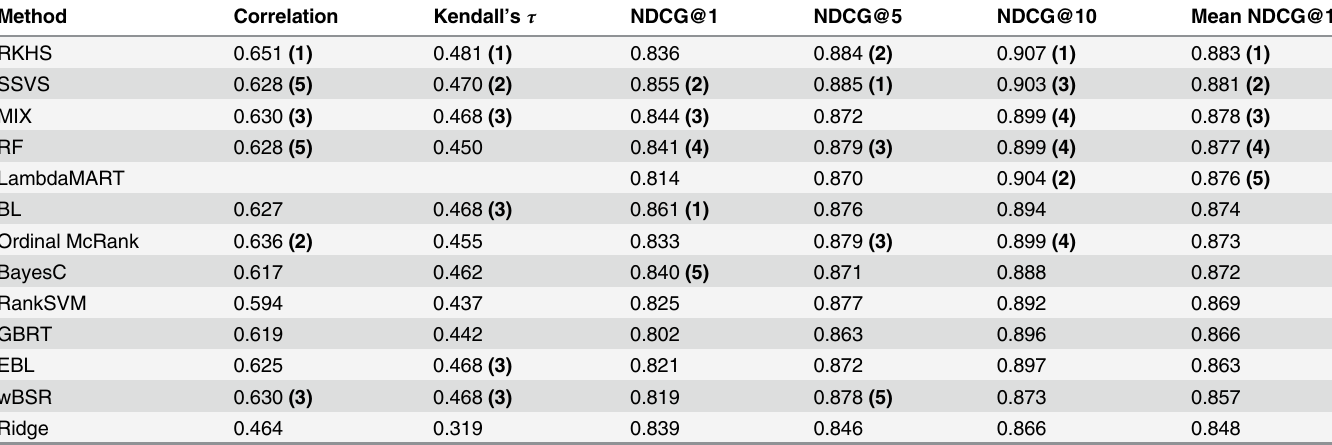
Table 2. Cross-validation results on the Arabidopsis thaliana dataset, averaged across 3 traits.